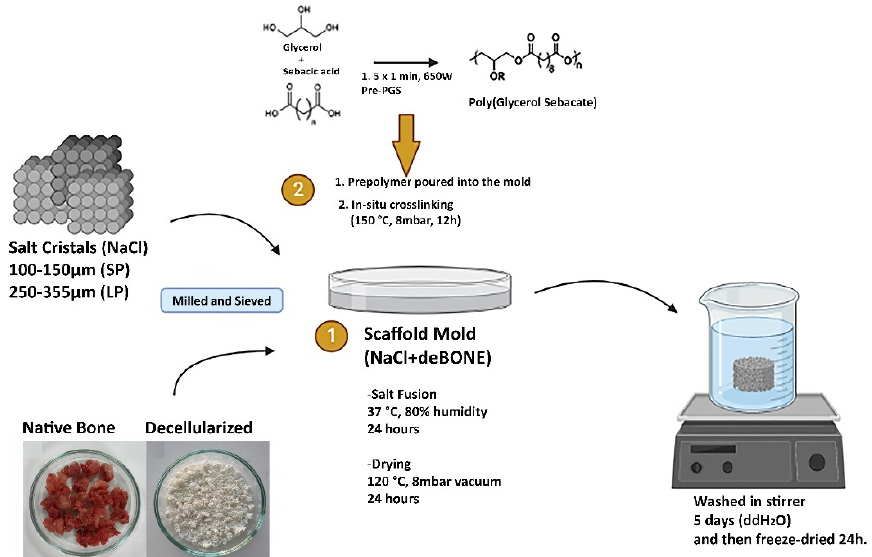
Figure 1. Schematic of the fabrication of the PGS/deB blend scaffolds. Stage 1 consisted of creating a scaffold template by blending the milled and sieved salt crystals (NaCl) (100–150 µ m: small pores (SP) and 250–355 µ m: large pores (LP)) with the decellularized bone powder followed by the in situ crosslinking of the prepolymer poured into the scaffold mold (Stage